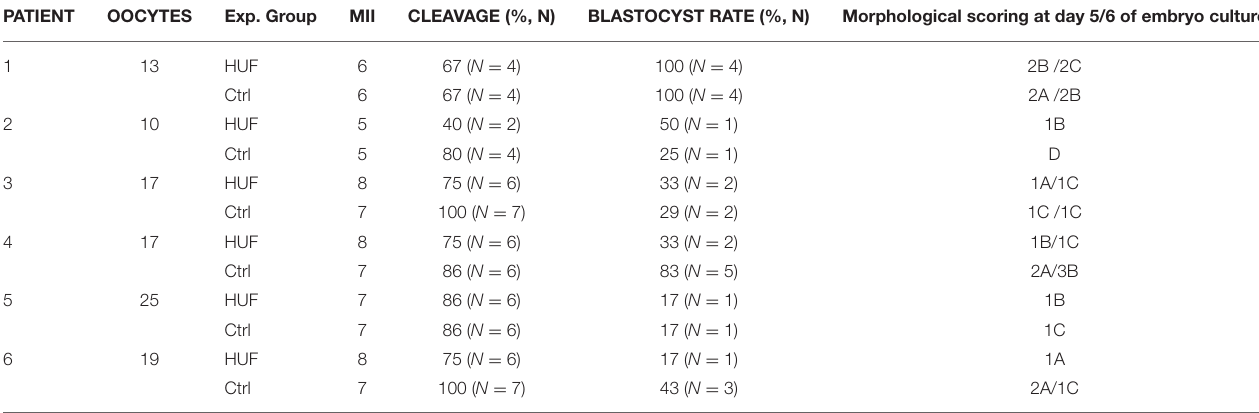
TABLE 4B | Blastocyst rate and embryo quality according to morphological criteria described previously (Staicu et al., 2021) of control vs. 10% HUF embryos of each patient who accepted to participate in the proof-of-concept NCT03436758QC and fulfilled all the inclusion criteria, namely, the retrieval of at least eight metaphase II oocytes, and transfer of their embryos.